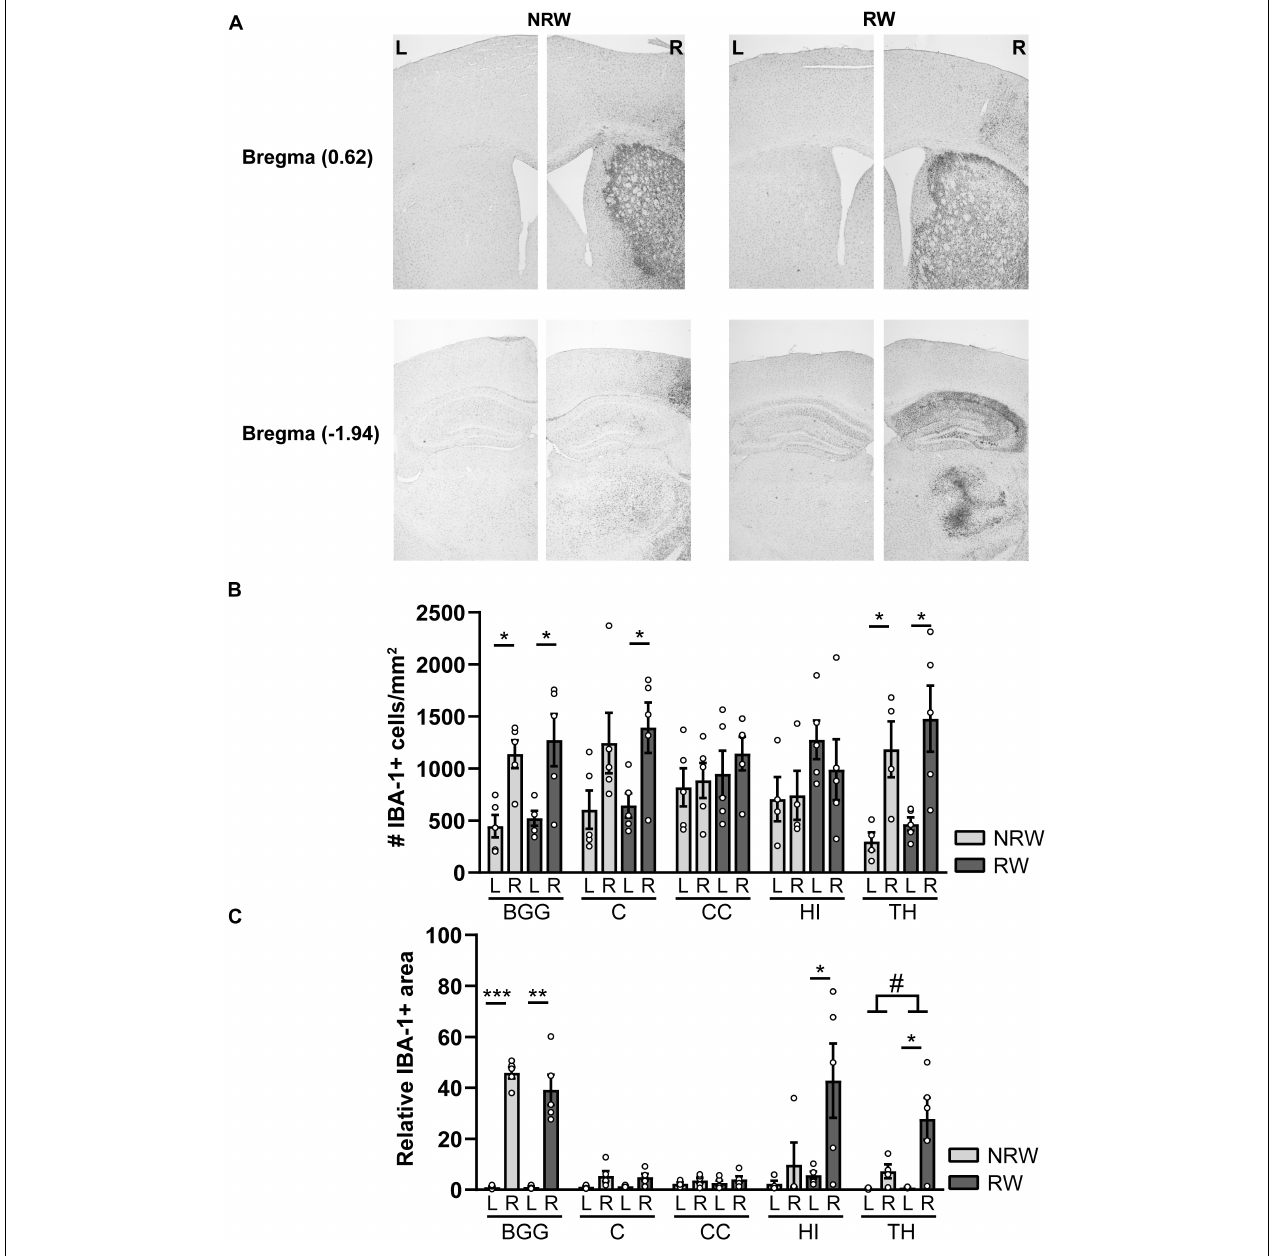
FIGURE 9 | Immunohistochemical staining for IBA-1 in brains of mice with (RW) and without a running wheel (NRW) performed 1 week after stroke induction. (A) Representative images of the IBA-1 staining in the ipsilateral (R: right) and contralateral (L: left) hemisphere of bregma –1.94 and 0.62 in RW and NRW animals. (B) Number of IBA-1+ positive cells and (C) relative IBA-1+ area in different ROI (BGG: basal ganglia, C: cortex, CC: corpus callosum, H: hippocampus, TH: thalamus) were calculated. RW: N = 5, NRW: N = 4; values represented in mean ± SEM. # 0.05 < p < 0.08 (tendency); * p ≤ 0.05; ** p ≤ 0.01; *** p ≤